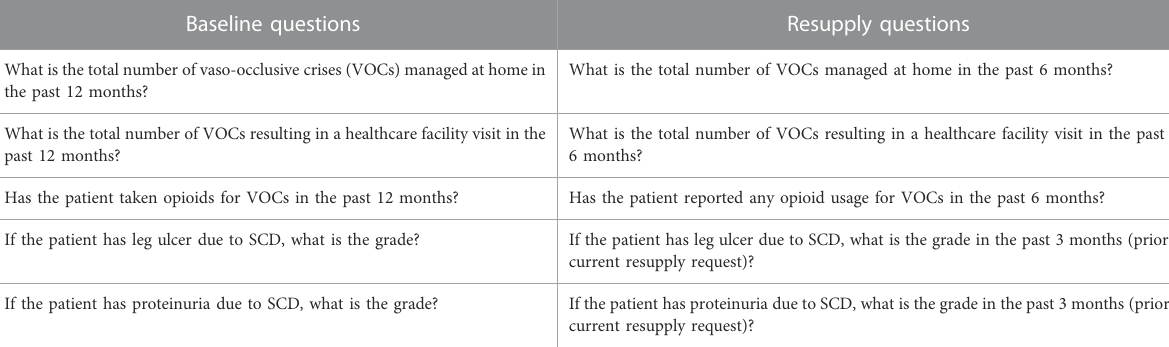
TABLE 2 Example of complementary baseline and resupply questions for sickle cell disease